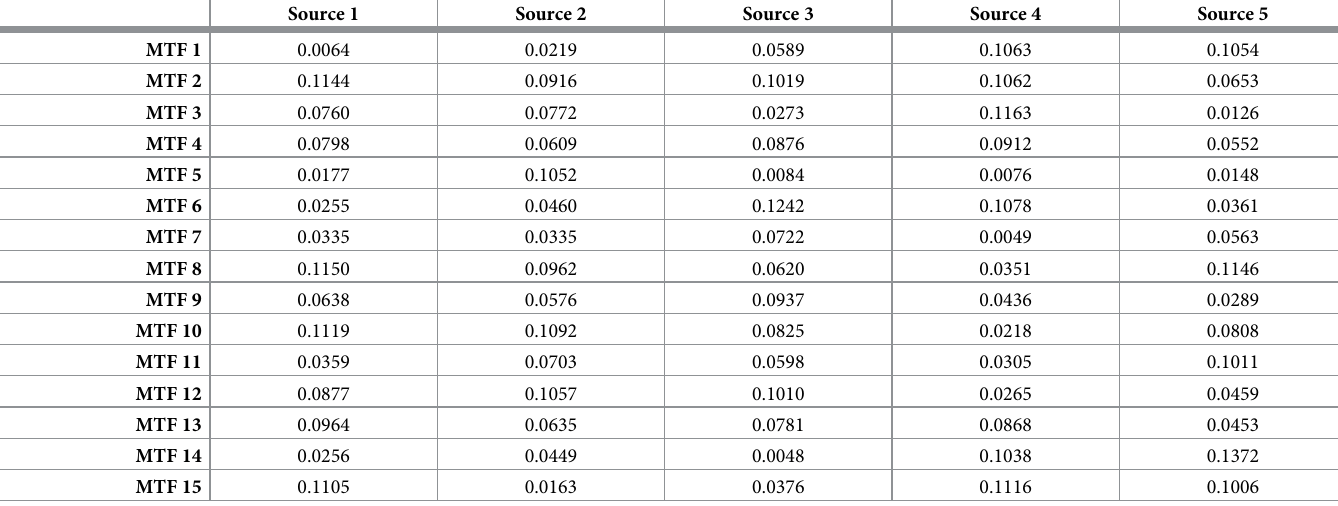
Table 2. Probability that a casualty from a given source will be directed to a given